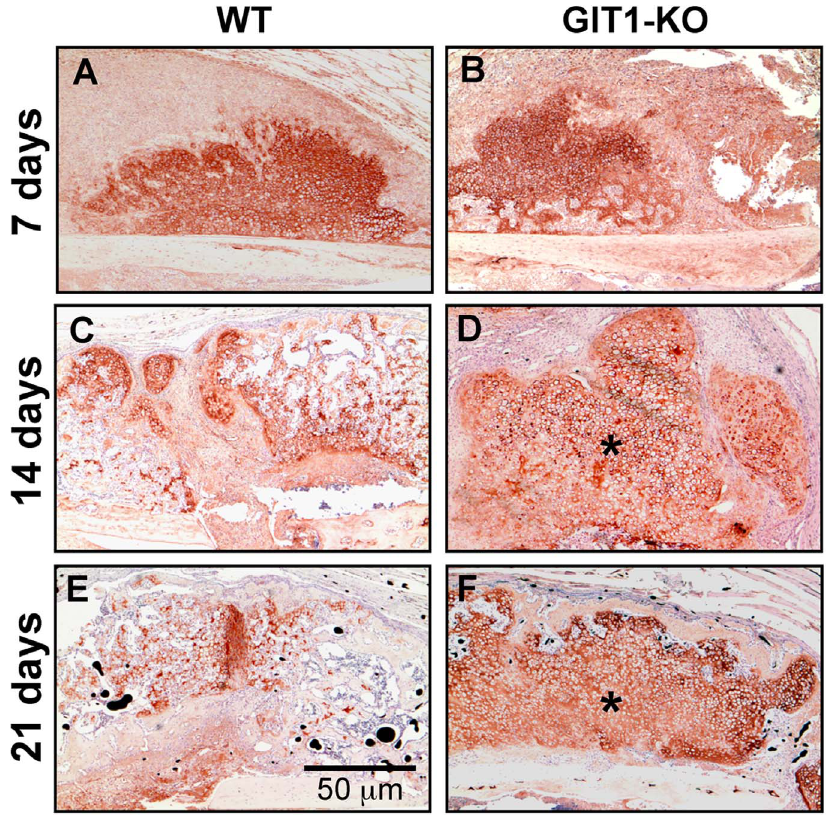
Figure 4. Type 2 collagen-containing matrix persists in GIT1 KO mice. Tissue sections cut from WT and GIT1 KO mice were analyzed for COL2A1 content using an immunohistochemistry approach. Representative stains at 7, 14 and 21 days post-fracture are depicted, with asterisks denoting areas within the callus at 2 and 3 weeks post-fracture in GIT1 KO mice (D and F respectively) that have more robust/persistent staining. mice (Fig. 2D, red arrows indicating disjunction) compared to WT mice (Fig. 2C) at 14 days post-fracture, although quantification of mineralized callus volume in cohorts of animals failed to achieve significance at any timepoint, only revealing a trend toward a decrease (Fig. 2E).